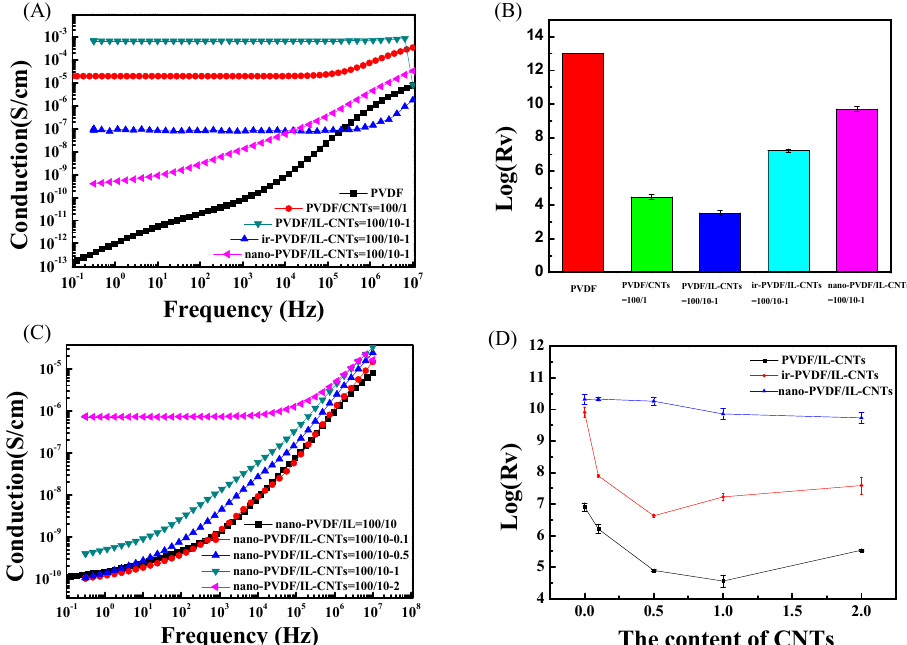
Figure 6. Electrical properties of PVDF and PVDF-based samples. ( A , B ) are AC conductivity and surface resistivity (Rs) of typical samples including neat PVDF, PVDF/CNTs (100/1), PVDF/IL-CNTs (100/10-1), ir-PVDF/IL-CNTs (100/10-1) and nano-PVDF/IL-CNTs (100/10-1), respectively; ( C ) AC conductivity of nano-PVDF/IL-CNTs samples with various CNTs loading levels; ( D ) Rv values of three typical systems, including PVDF/IL-CNTs, as-irradiated PVDF/IL-CNTs and nano-PVDF/IL-CNTs with different CNTs contents.